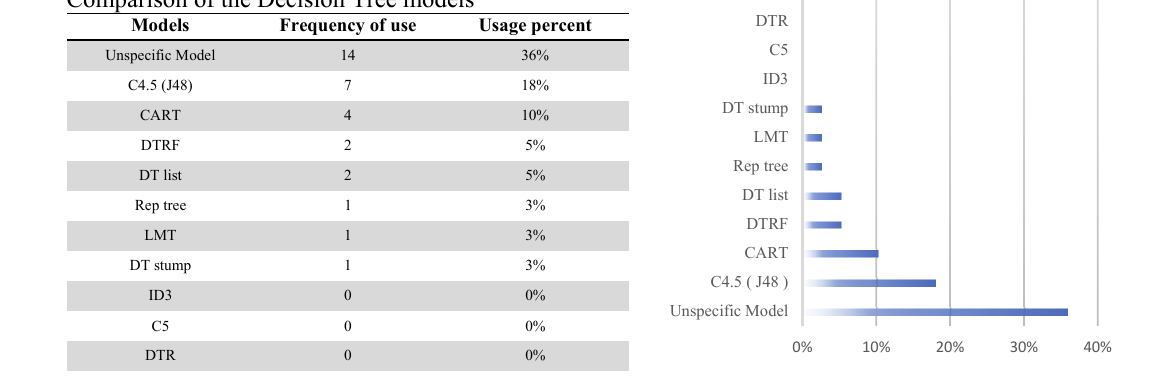
Fig. 4. Comparison of the Decision Tree models